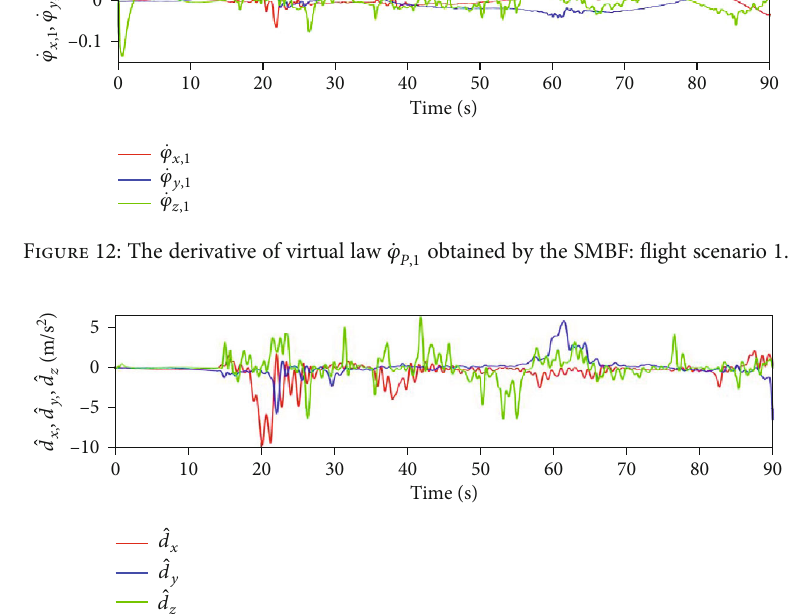
Figure 13: Estimated lumped disturbances for the translational subsystem by the FXESO: fl ight scenario